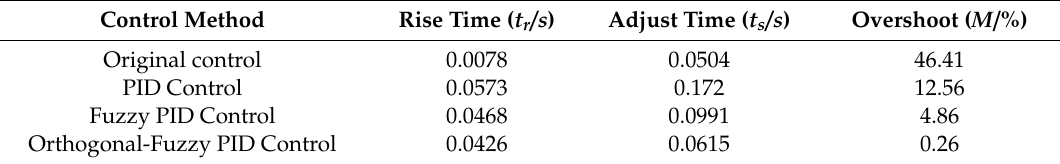
Figure 8. Orthogonal-Fuzzy PID control Simulink simulation results. Table 8. Orthogonal-Fuzzy PID control simulation